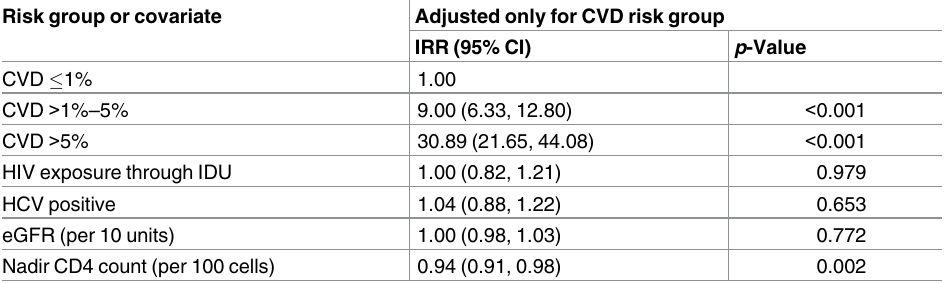
Table 5. Covariates of CKD risk score as predictors for CVD events adjusted for CVD risk group. Risk group or